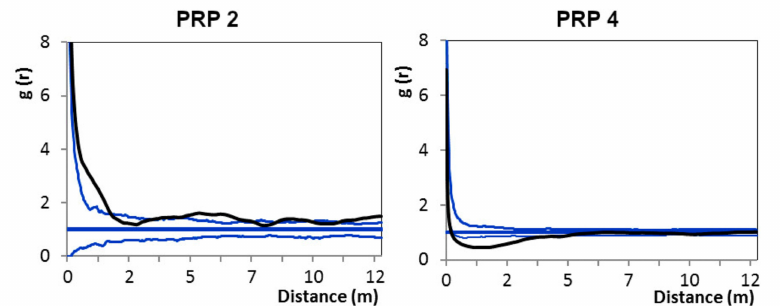
Figure 7. Relationships of the spatial pattern of recruits and the overstory expressed by the pair correlation function on permanent research plots (PRP) 2 (rhododendron cleared) and permanent research plots 4 (no intervention); bold black line represents the pair cross function for real distances of trees; blue line on the level of g ( r ) = 1 represents the mean course for random spatial distribution of trees; and two thick blue curves represent 95% interval of reliability; if the observed value (black line) exceeds the upper (respectively lower) limit of the simulation interval, it indicates significant aggregation—positive relationship between two tested groups (respectively inhibition—negative